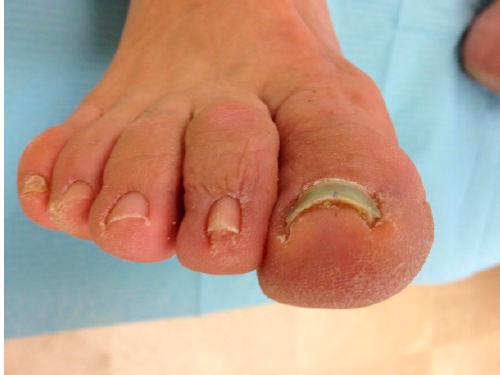
Figure 3. Appearance at 6 months.